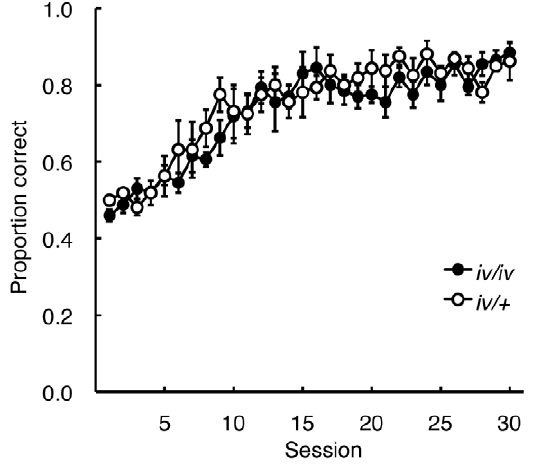
Figure 5. Acquisition of the delayed nonmatching-to-position (DNMTP) in iv/iv and iv/ + mice. During DNTP training with a 0-s programmed delay interval, both iv/iv and iv/ + mice acquired the task equally